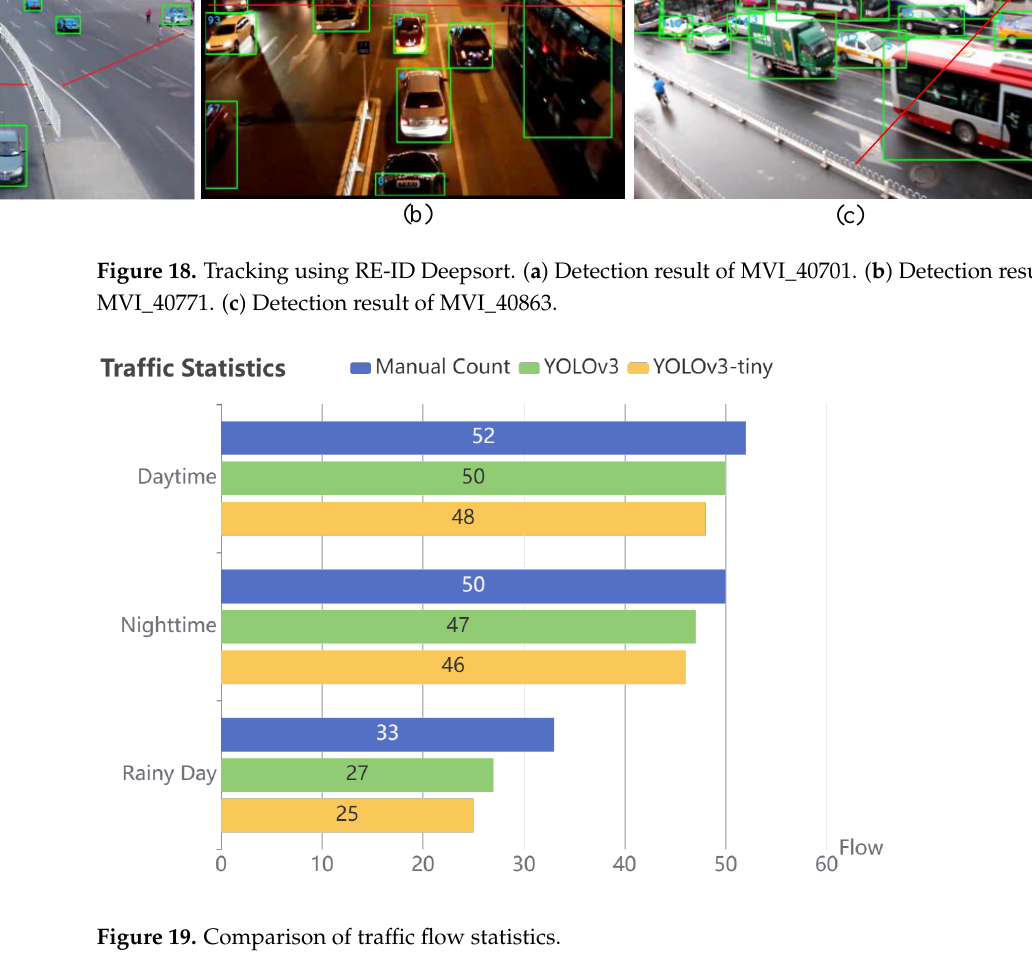
Figure 19. Comparison of traffic flow